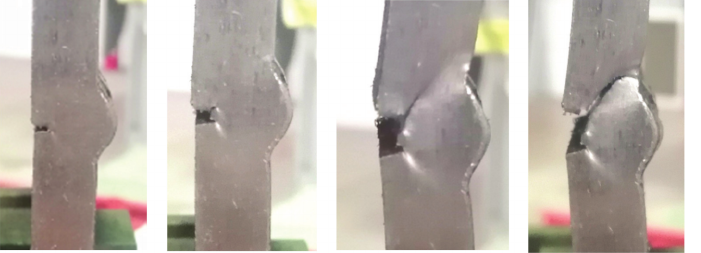
Figure 14. Tensile test specimens during the experiment (excess weld metal, undercut, incomplete root penetration) from the initial state to